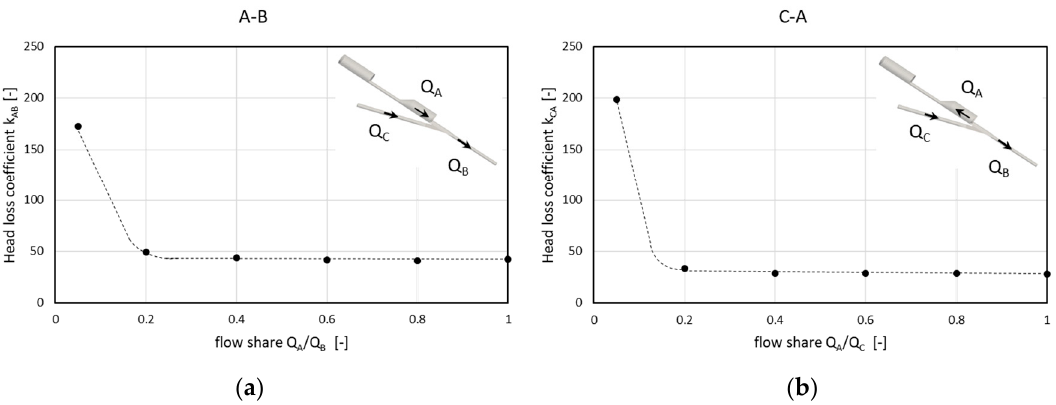
Figure 10. ( a ) Variation of k AB with the flow share; ( b ) Variation of k CA with the flow share .